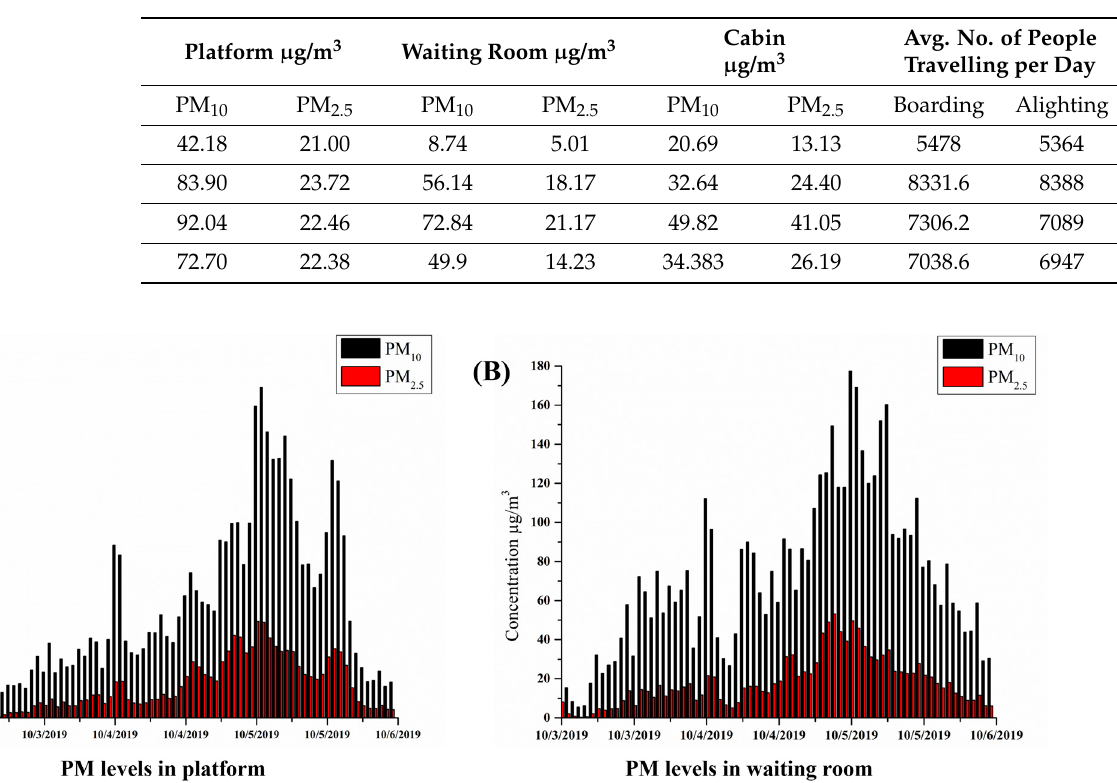
Figure 1. ( A ) PM 10 and PM 2.5 concentrations on the platform, ( B ) PM 10 and PM 2.5 concentrations in the waiting room.